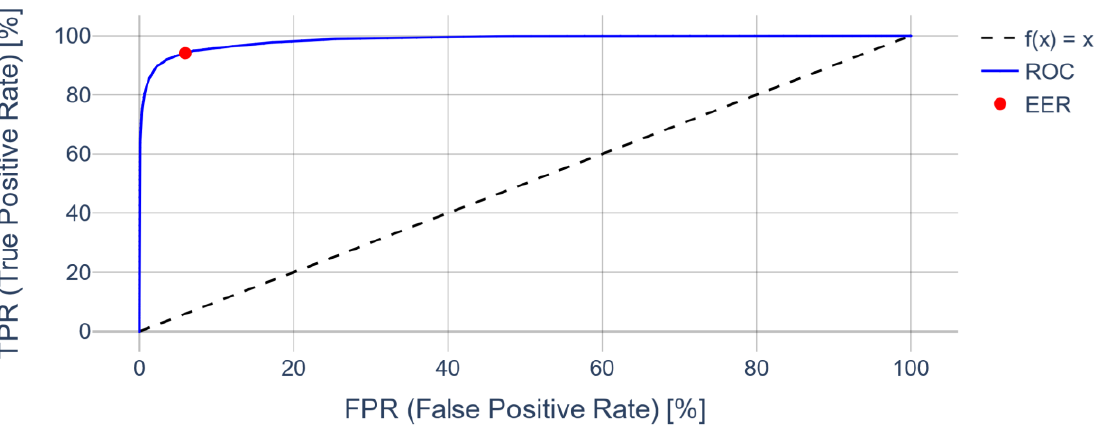
Figure 10. Receiver operating characteristic (ROC) curve for neural network evaluated on a validation set consisting of 200 clients with 1043 signatures in total.